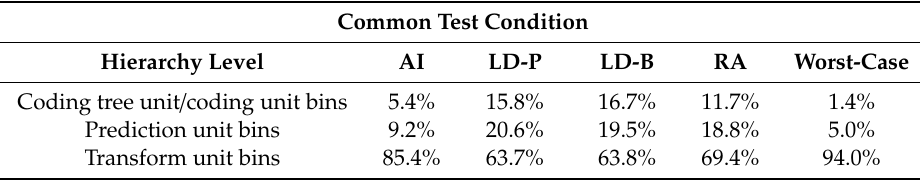
Table 1. Major bins contributors among HEVC data hierarchy [7].